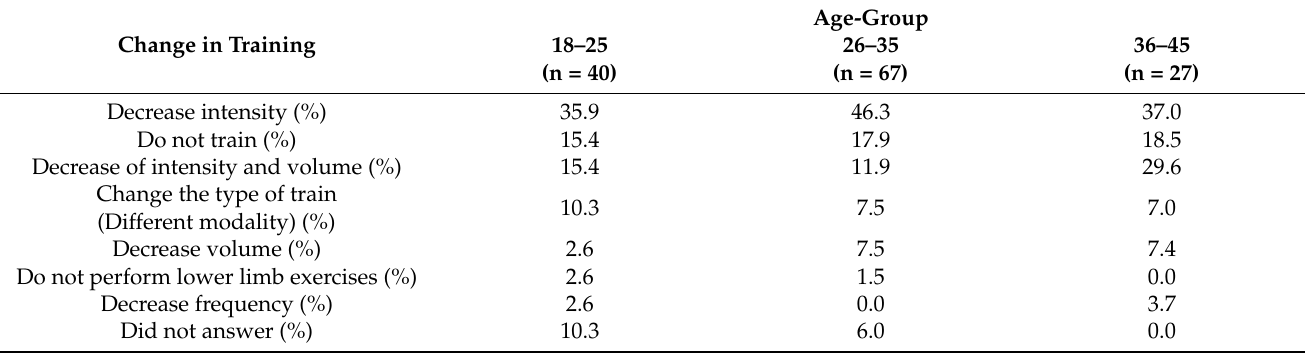
Table 1. Training adjustments according to their period with a symptomatic phase of MC (n =